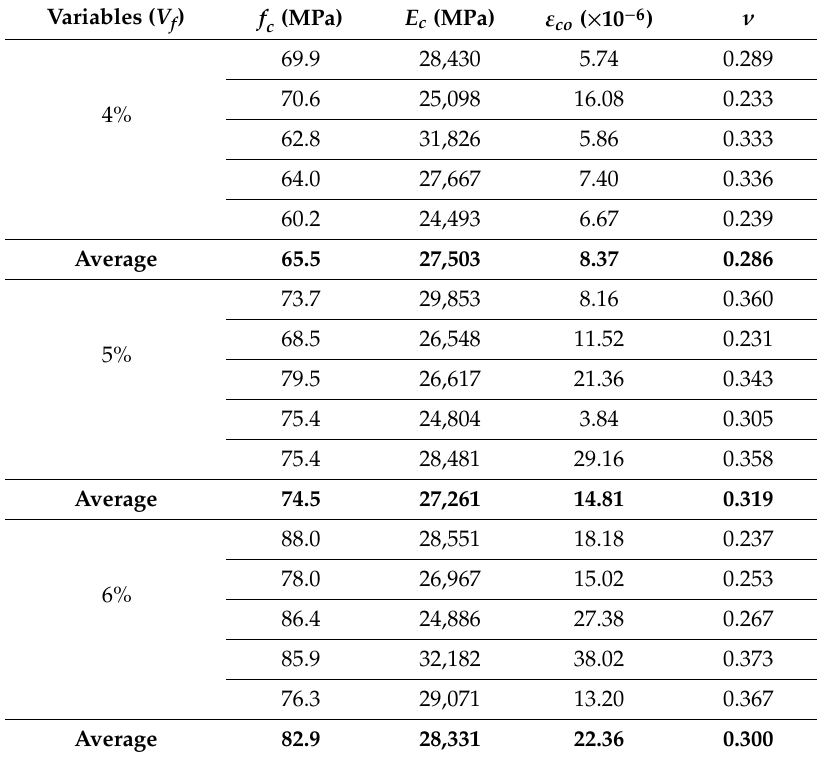
Table 5. Experimental results for compressive behavior characteristics with respect to the fiber volume